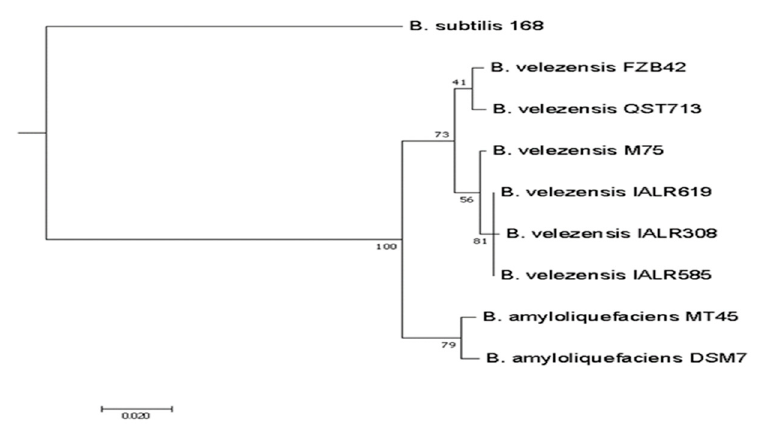
Figure 4. Phylogenetic tree based on the proteomes of IALR308, IALR585, and IALR619. These iso- lates grouped closely to reference Bacillus velezensis M75. The tree has been rooted using the out- group B. subtilis 168. The reference proteomes included B. velezensis FZB42 (NC_009725.1), B. vele-